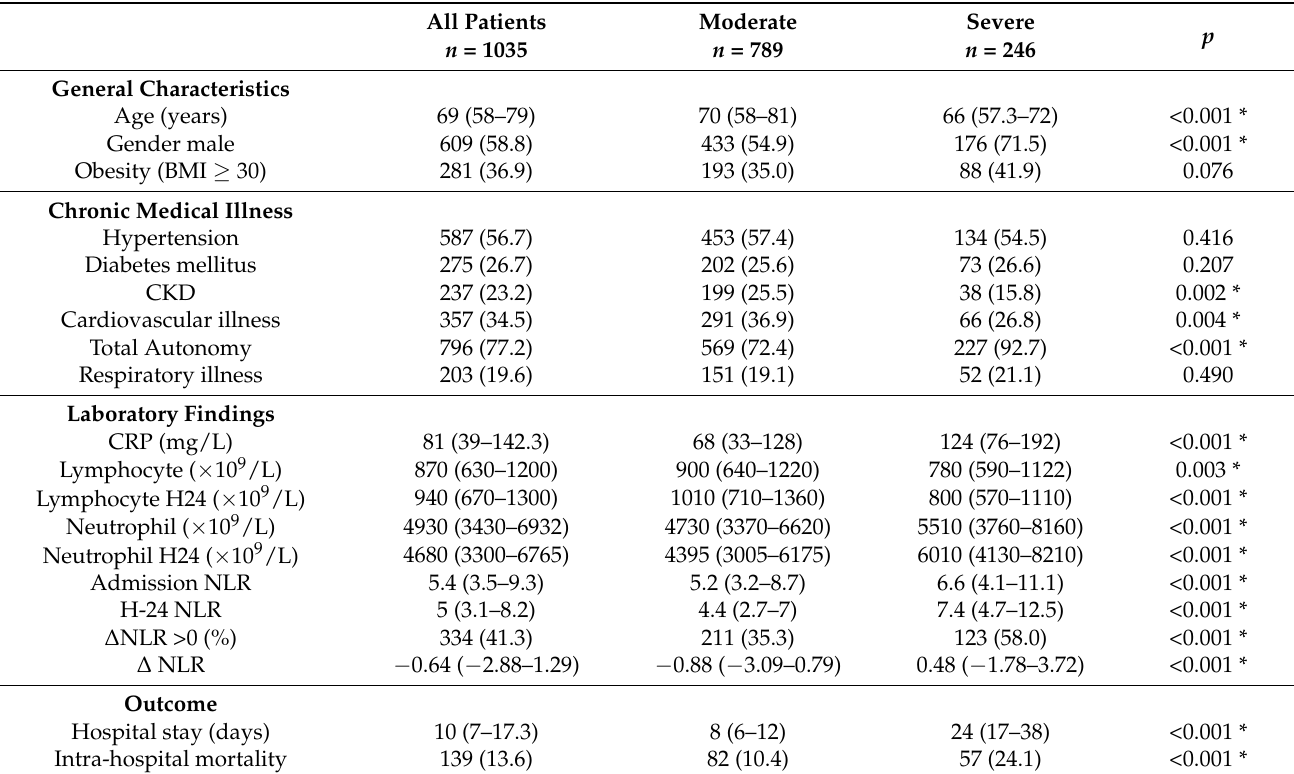
Table 1. Demographic, baseline, and laboratory characteristics of patients with